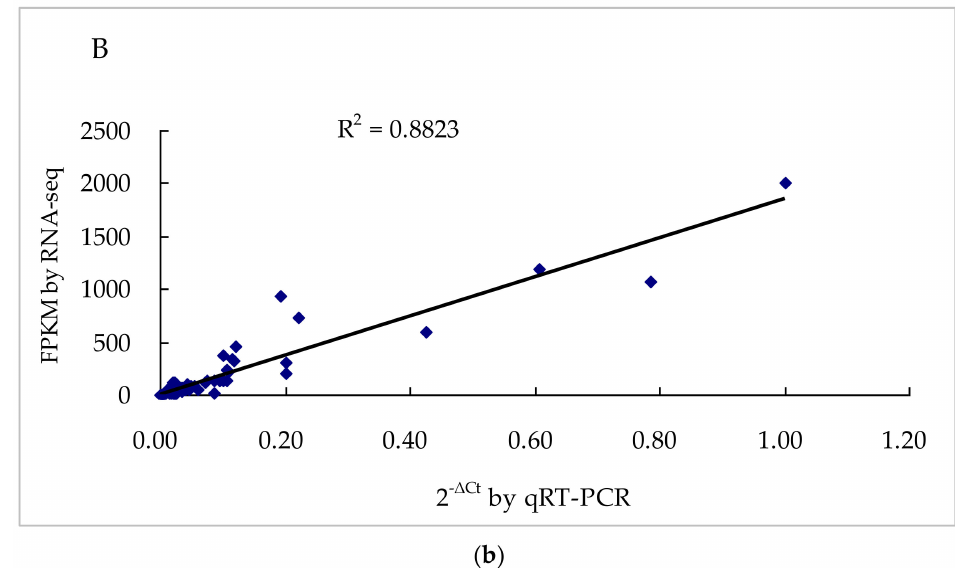
Figure 9. Expression analysis for structural genes involved in anthocyanin accumulation. ( A ) Expression level analysis of key structural genes involved in anthocyanin biosynthesis in pink tea flower development stages. ( B ) Correlation analysis based on RNA-seq and qRT-PCR